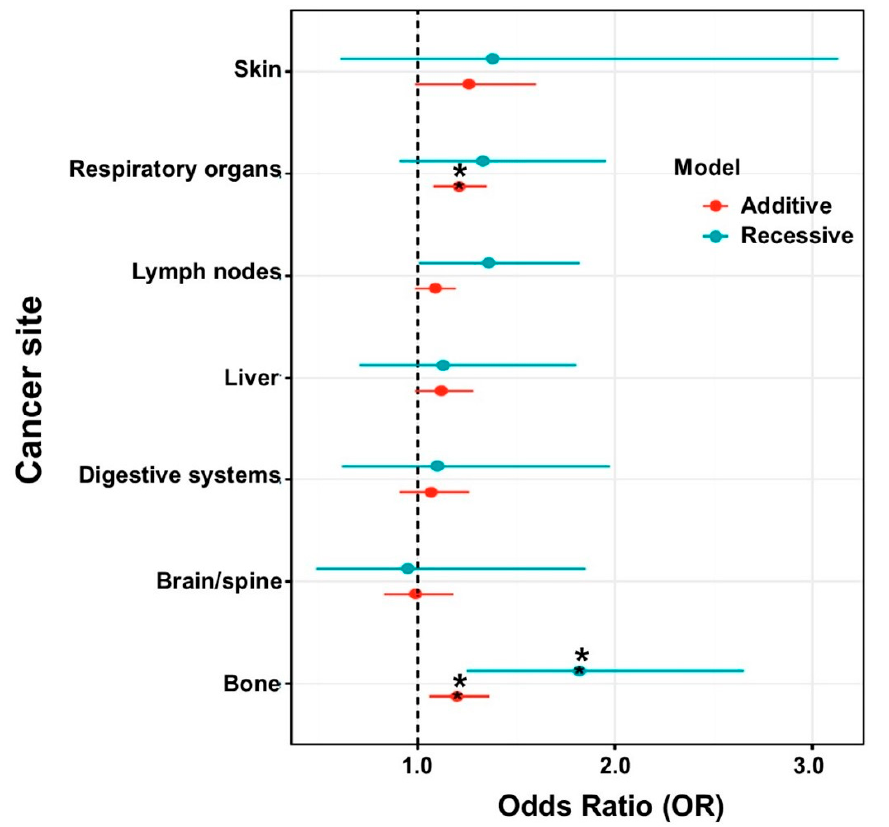
Figure 3. Association of circulating calcium levels with secondary cancer phenotypes. Logistic regression models were performed on secondary cancer and the CASR variants at rs1801725. The additive (red) and recessive (green) models were adjusted for median age, sex, and the first ten principal components. * indicates p < 0.01 in the logistic regression model. OR = odds ratio.